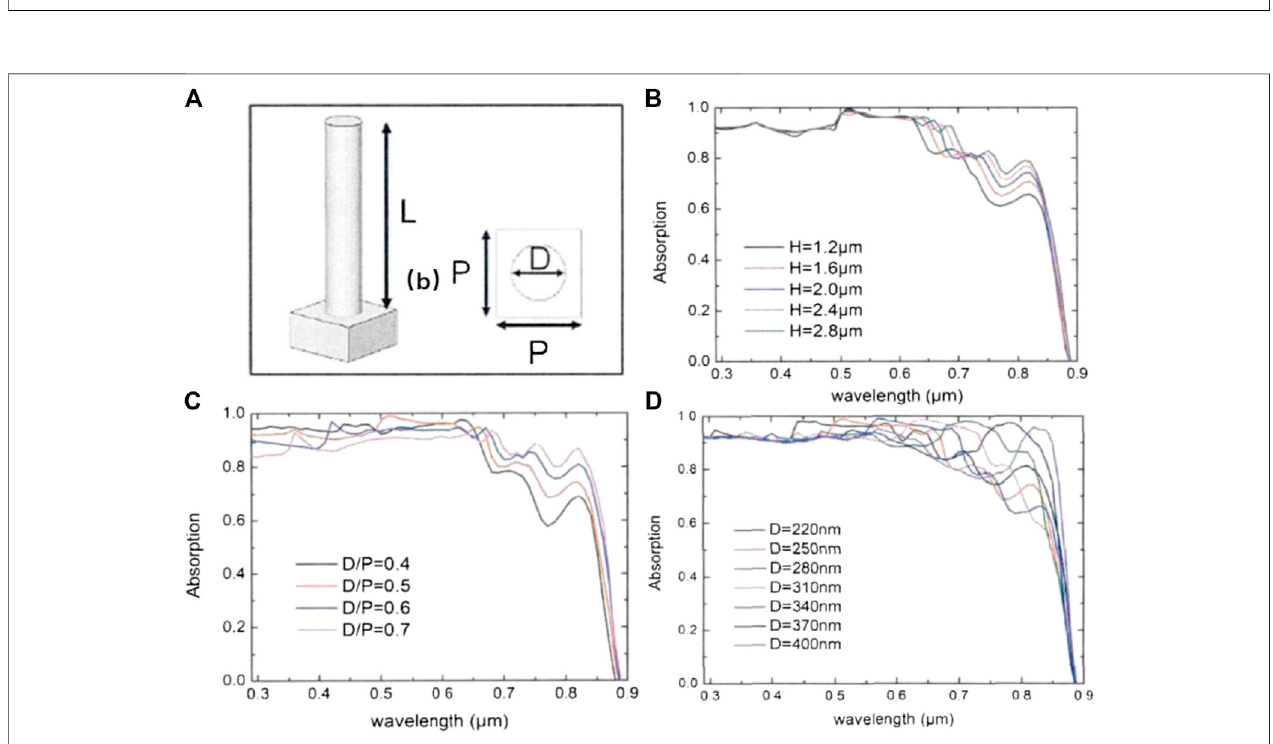
Frontiers in Physics |